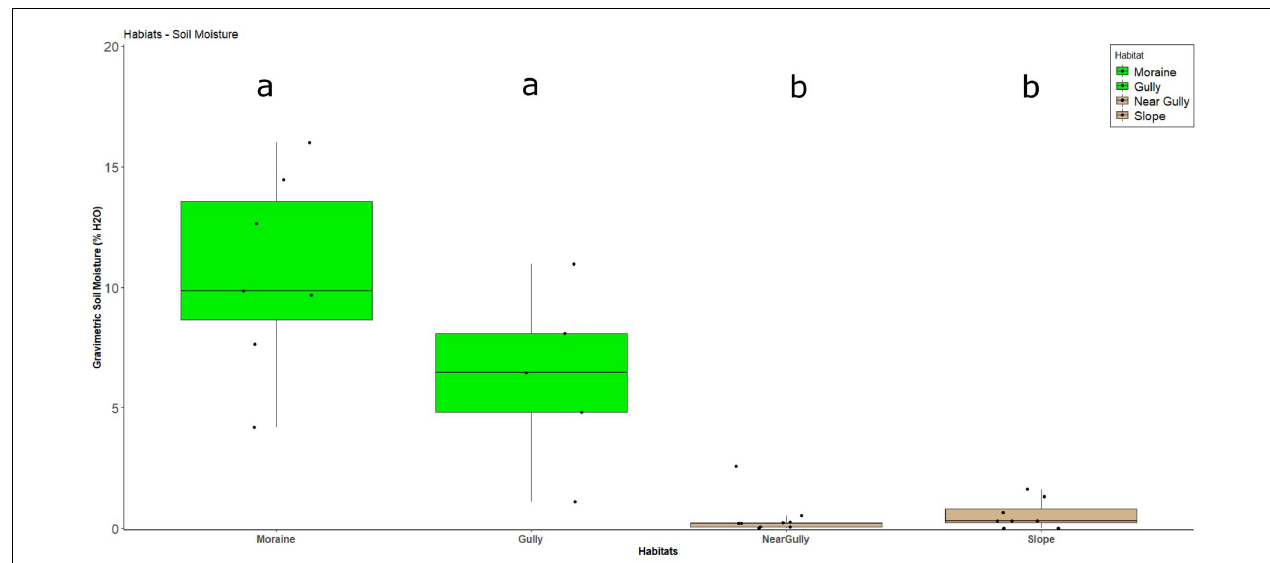
FIGURE 2 | Soil moisture boxplots of gravimetric soil moisture by habitat. Green identifies habitats with crusts. Non-crust habitats are in tan. Each dot is a single sample, the box represents the 25–75% quartile values, and the dark line in the box represents median values of soil moisture. Lower-case letters indicate the presence of statistical difference among habitats as determined by pairwise Dunn tests.